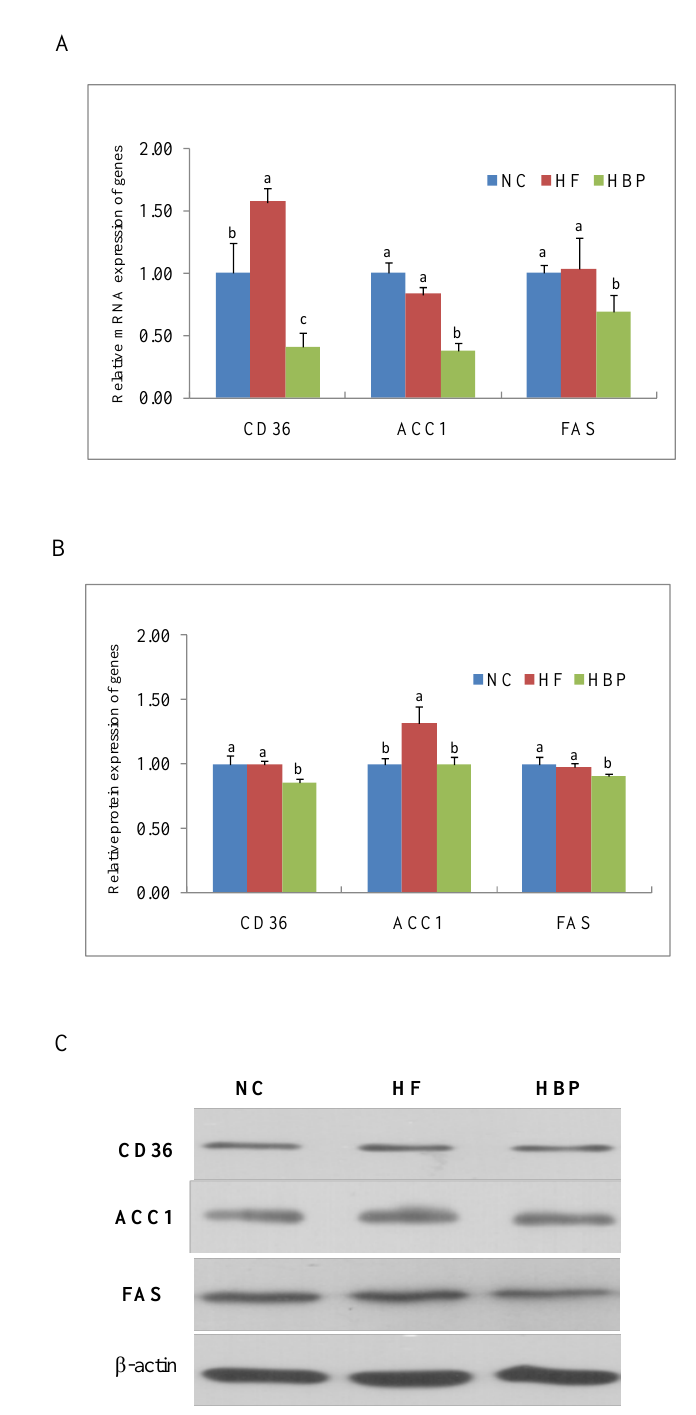
Figure 3. Effects of HBP on the expression of genes related with fatty acid absorption and synthesis in the liver: ( A ) Relative mRNA level of CD36, ACC1, and FAS; ( B ) relative protein levels of CD36, ACC1, and FAS; ( C ) representative bands of immunoblot. Values not sharing a letter in common are significantly different, p <